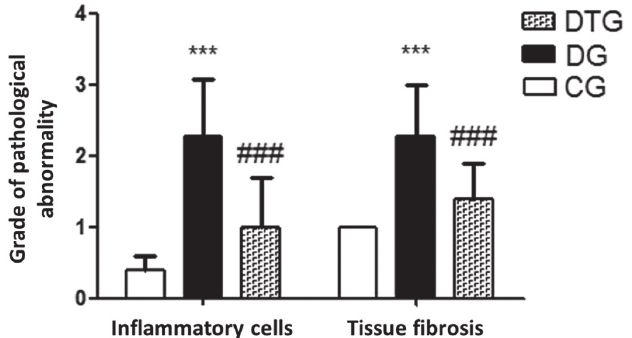
FIGURE 7 - The lung injury score (inflammation cells and tissue fibrosis) in different groups. Lung fragments were removed 24 hours after the last day of the experiment and stained with hematoxylin and eosin (HE), at 100x magnification. Data appear as mean ± SD. CG (control group),